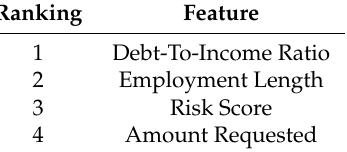
Figure 3. Risk Score feature transformed with the cubic spline. Table 1. Features Ranking with MATLAB Subroutine “Rankfeatures” (ROC is the criterion).